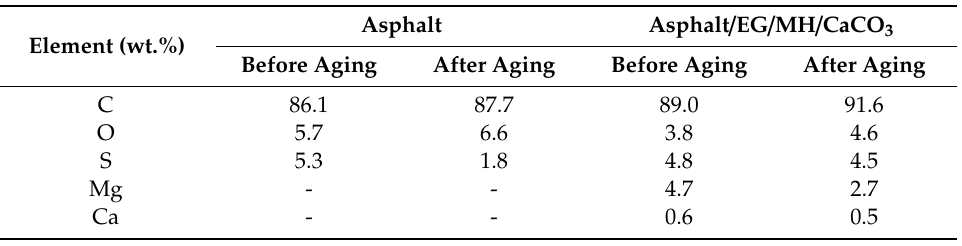
Table 2. Elemental content changes of asphalt and asphalt / EG / MH / CaCO 3 before and after the isothermal-oxidative